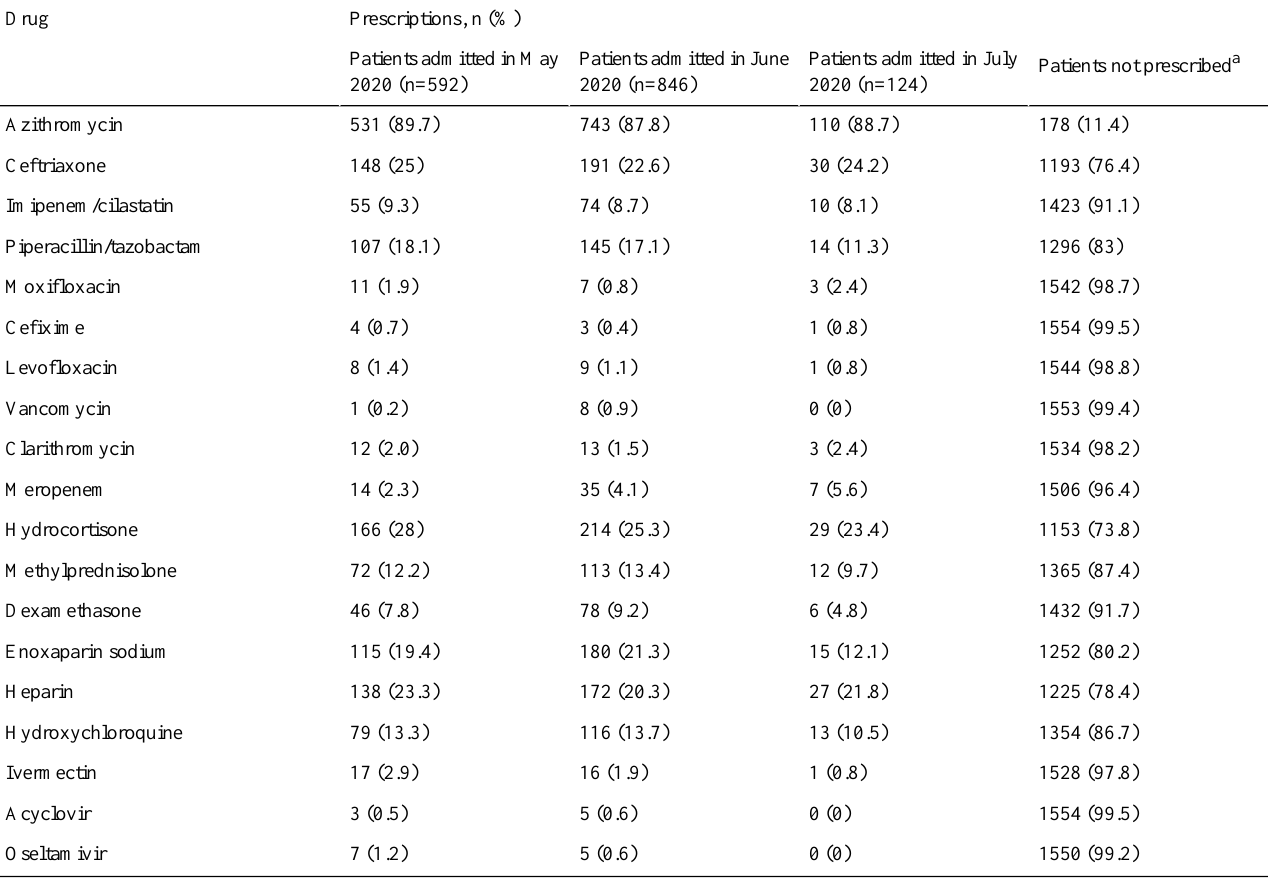
a Percentages calculated based on the total number of patients across 3 months